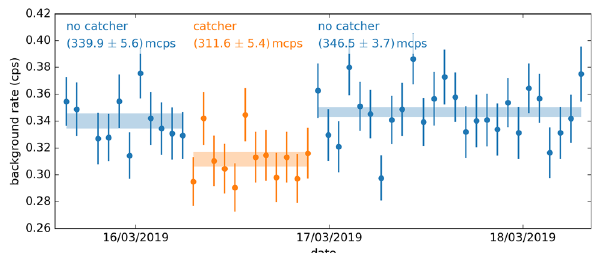
Fig. 14 Electron rate during measurements with about 2 . 5 × 10 17 T 2 molecules / cm 2 tritium column density both with and with- out electron catcher operation (setting H, Table 1). When in operation, the catcher was moved into the flux tube for 5 s when the retarding voltage was changed. A reduction of 20 mcps was observed when the catcher was used, indicating the presence of a Penning-trap-induced background when the catcher was not